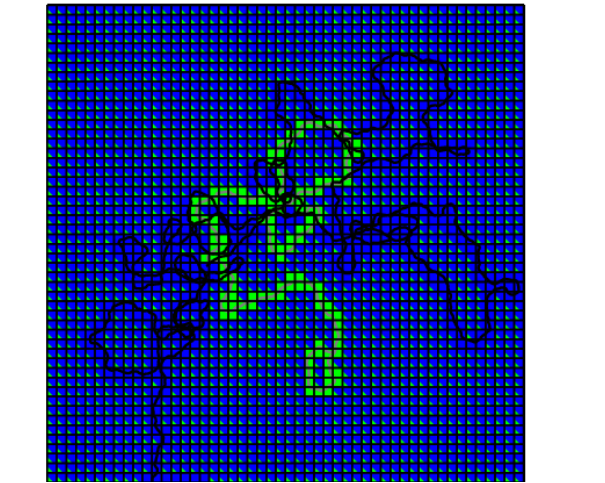
Figure 2. Sketch of the contrast situation -highlighted by the traces of one chain of each species" in a mixture of chains with di ff erent scattering length density (indicated by colors green and blue). Occupancy of "blue" and "green" segments of "other" chains simply governed by their volume fractions is indicated by the fraction green triangles in these cells- of chain occupancy (simple RPA) at cells occupied by other chains. Yielding large "matrix" contrast for the minority ( ϕ = 0 . 2) short, "green" chains and lesser but nonzero contrast for the majority, "blue" chains. The mutually created visibility leads to crosstalk of the relax- ation dynamics of bot chains in the scattering signal, which may be described using dynamic